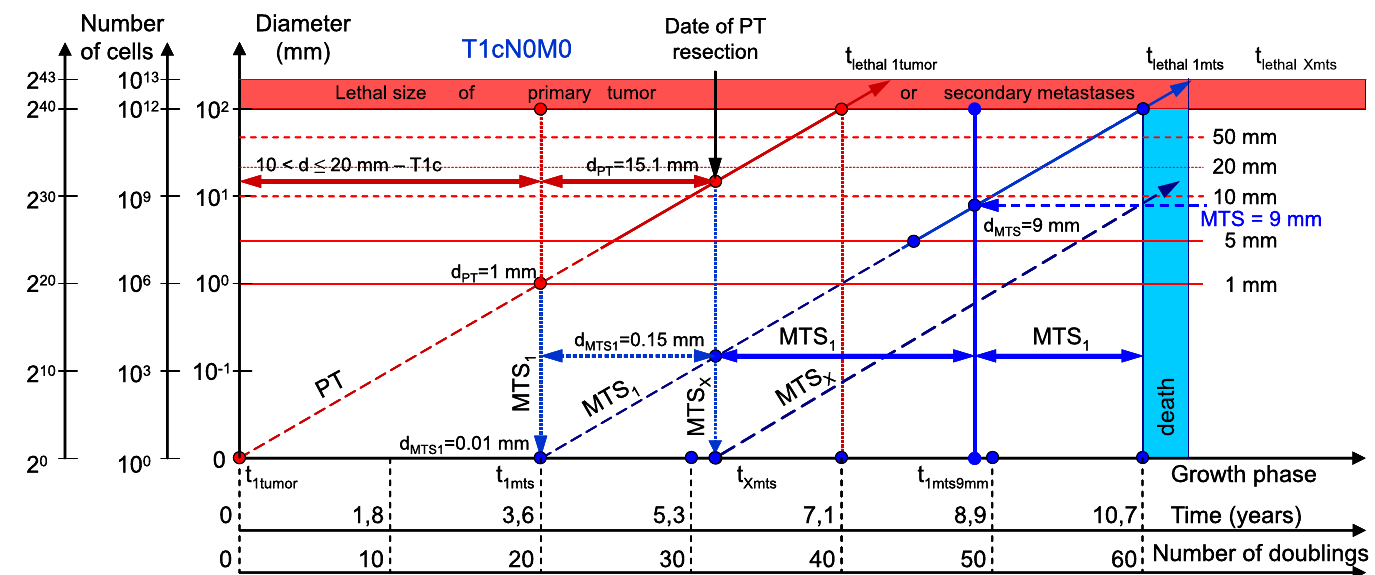
Fig 5. T1cN0M0. The whole natural history of PT and secondary distant MTS of patients without lymph nodes MTS via CoMPaS. Parameter T1c: 10 mm < d (cid:20) 20 mm. Diameter of PT at surgery of PT: d PT = 15.1 mm. Diameter of secondary distant MTS at surgery of PT: d MTS = 0.15 mm. https://doi.org/10.1371/journal.pone.0200148.g005 • the whole natural history of the PT and MTS growth (the period from the appearance of the first tumor cell up to death) was in range of 7.5 and 7.9 years for pT4.